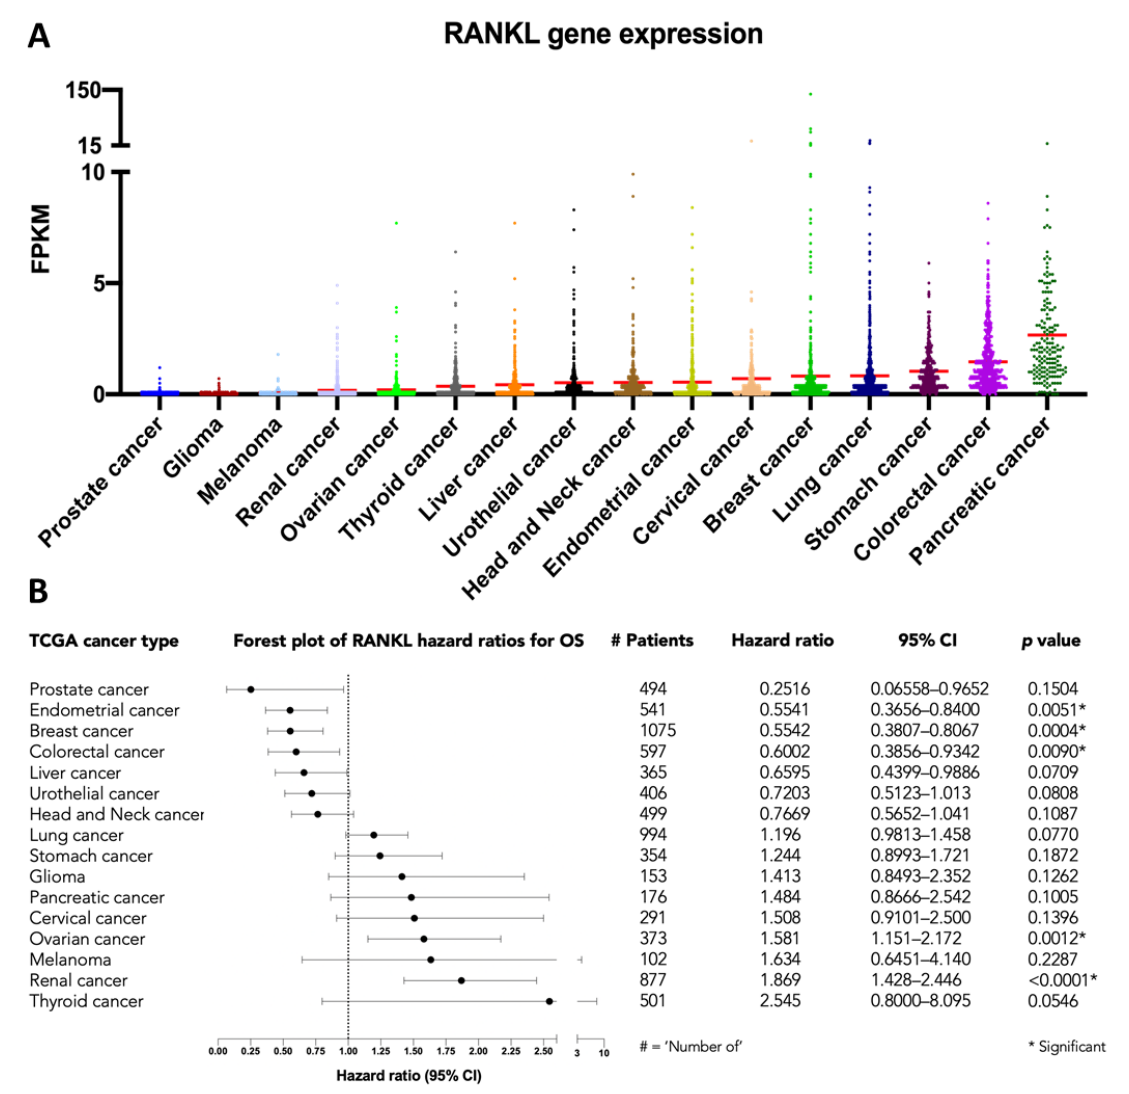
Figure 5. RANKL mRNA expression in 7798 patients with 16 different cancer types, available from The Cancer Genome Atlas (TCGA) database: ( A ) RANKL gene expression in Fragments Per Kilobase Million (FPKM), with red lines representing the mean, and ( B ) forest plot of the hazard ratios for overall survival (OS). Hazard ratios and the 95% confidence interval (CI) were estimated using the logrank method, as implemented in GraphPad.